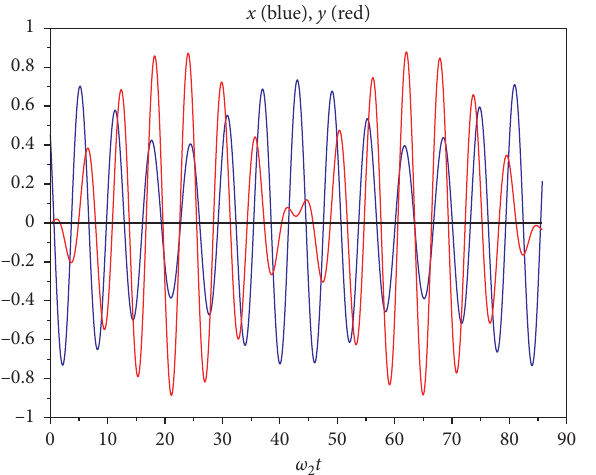
) and ( u ) versus / E / E 1 0 2 0